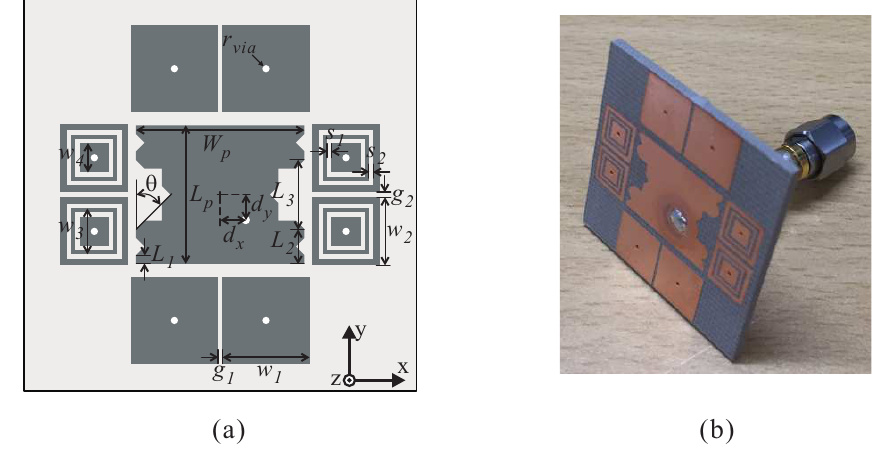
Figure 2. ( a ) Single CP Koch-shaped patch antenna with EBGs; ( b ) Photograph of the fabricated prototype. W p = 15.45 mm, L p = 12.69 mm, d x = 1.695 mm, d y = 1.966 mm, L 1 = 0.793 mm, L 2 = 3.173 mm, L 3 = 9.516 mm, θ = 45 ◦ , w 1 = 8.0 mm, g 1 = 0.4 mm, w 2 = 6.25 mm, g 2 = 0.5 mm, w 3 = 4.2 mm, w 4 = 2.7 mm, s 1 = 0.4 mm, s 2 = 0.4 mm and r via = 0.25